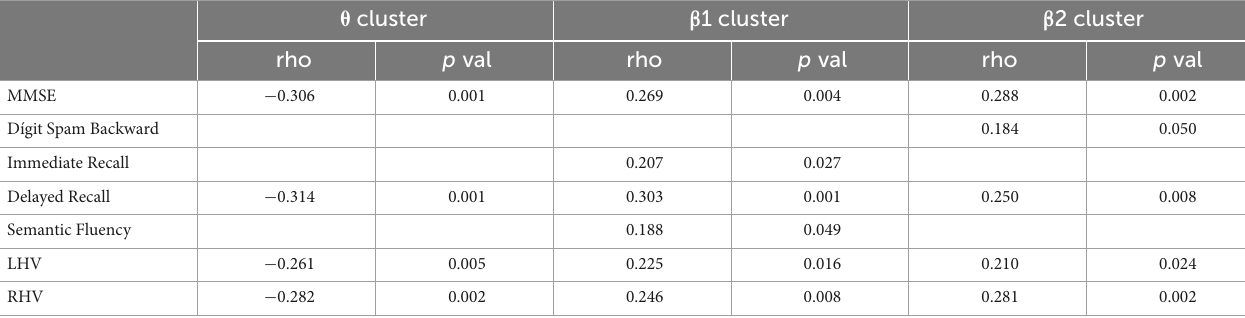
TABLE 2 Significant correlation between power markers and brain